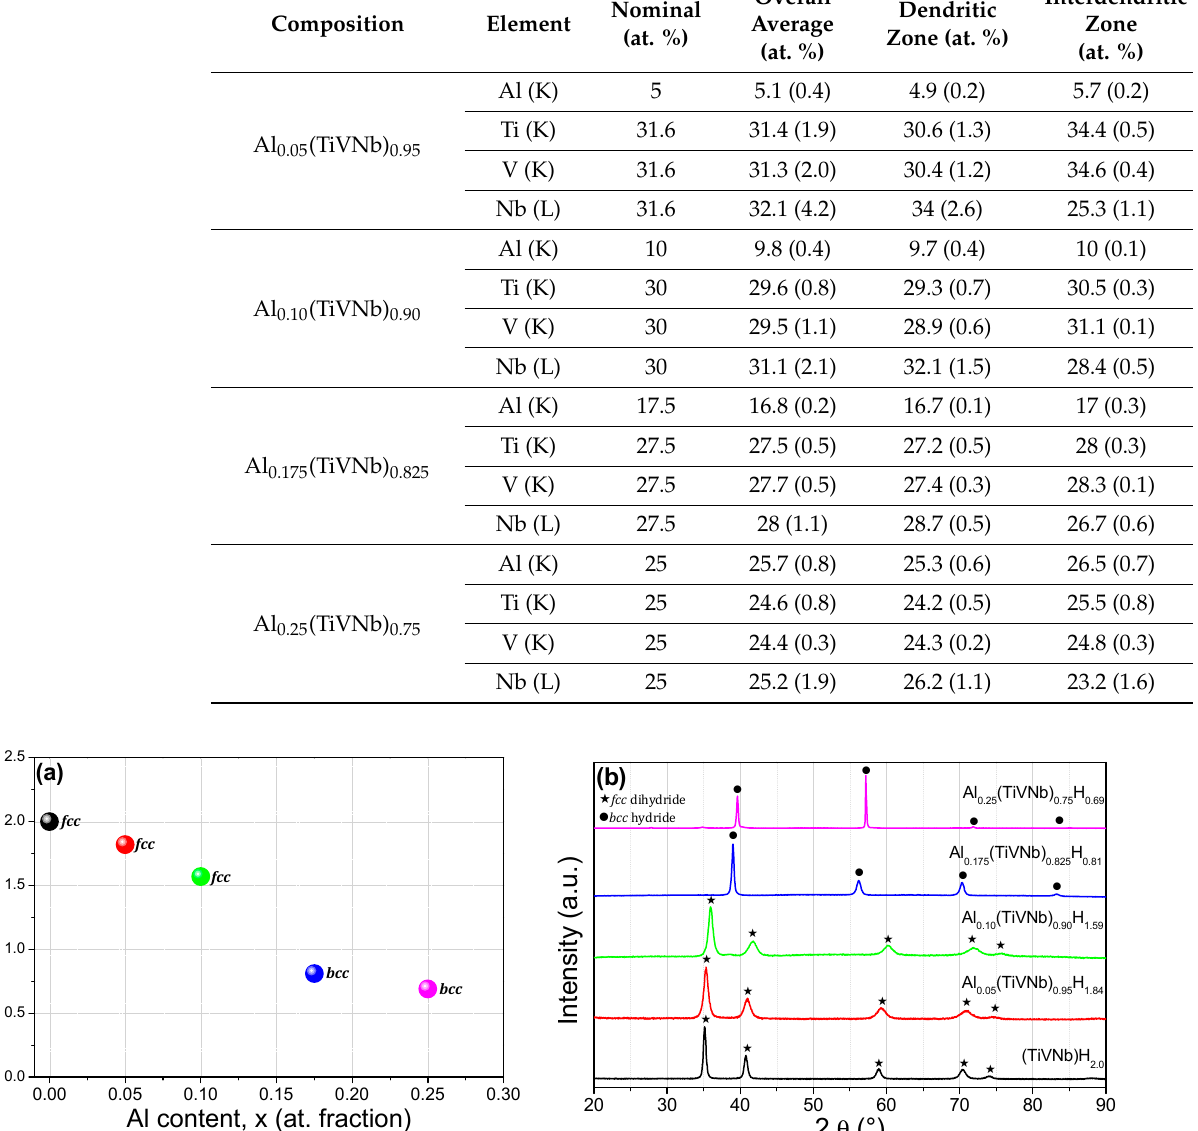
Table 3. EDX chemical analysis of the Al x (TiVNb) 1-x as-cast alloys with x = 0.05, 0.10, 0.175, 0.25.